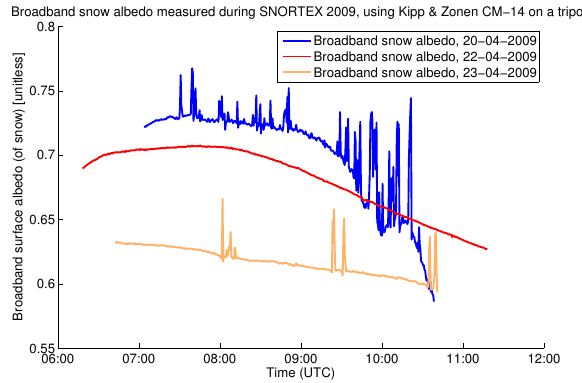
Fig. 5. The broadband erythemal UV albedo of snow from 17 April to 30 April 2009, measured with SL-501 radiometers, at the oper- ational albedo field of the Sodankyl¨a Arctic Research Center. The albedo declined slightly during each day: blue line for 08:00UTC, purple line for 12:00UTC.